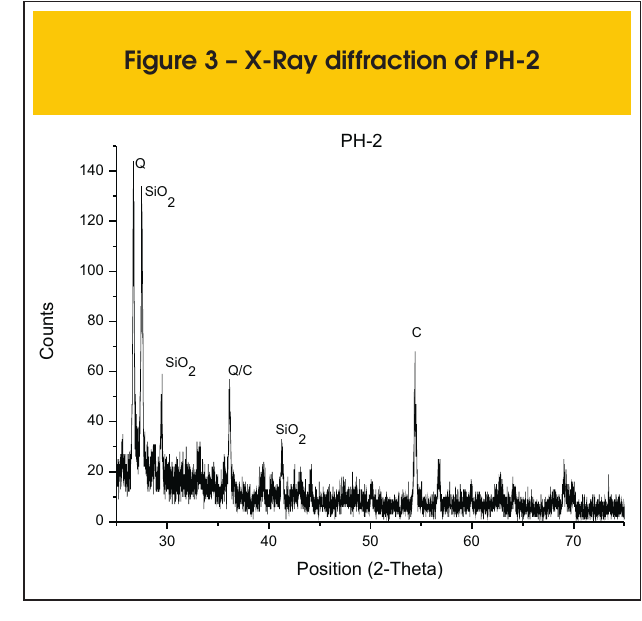
Figure 3 – X-Ray diffraction of PH-2